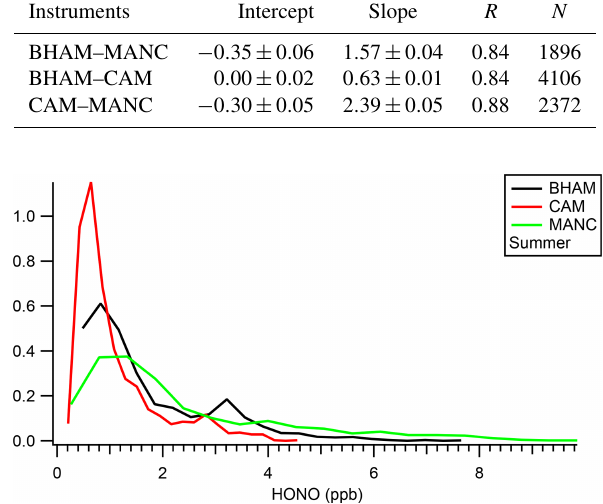
Figure 4. Histogram of measured summer concentrations (only for periods when all three instruments were